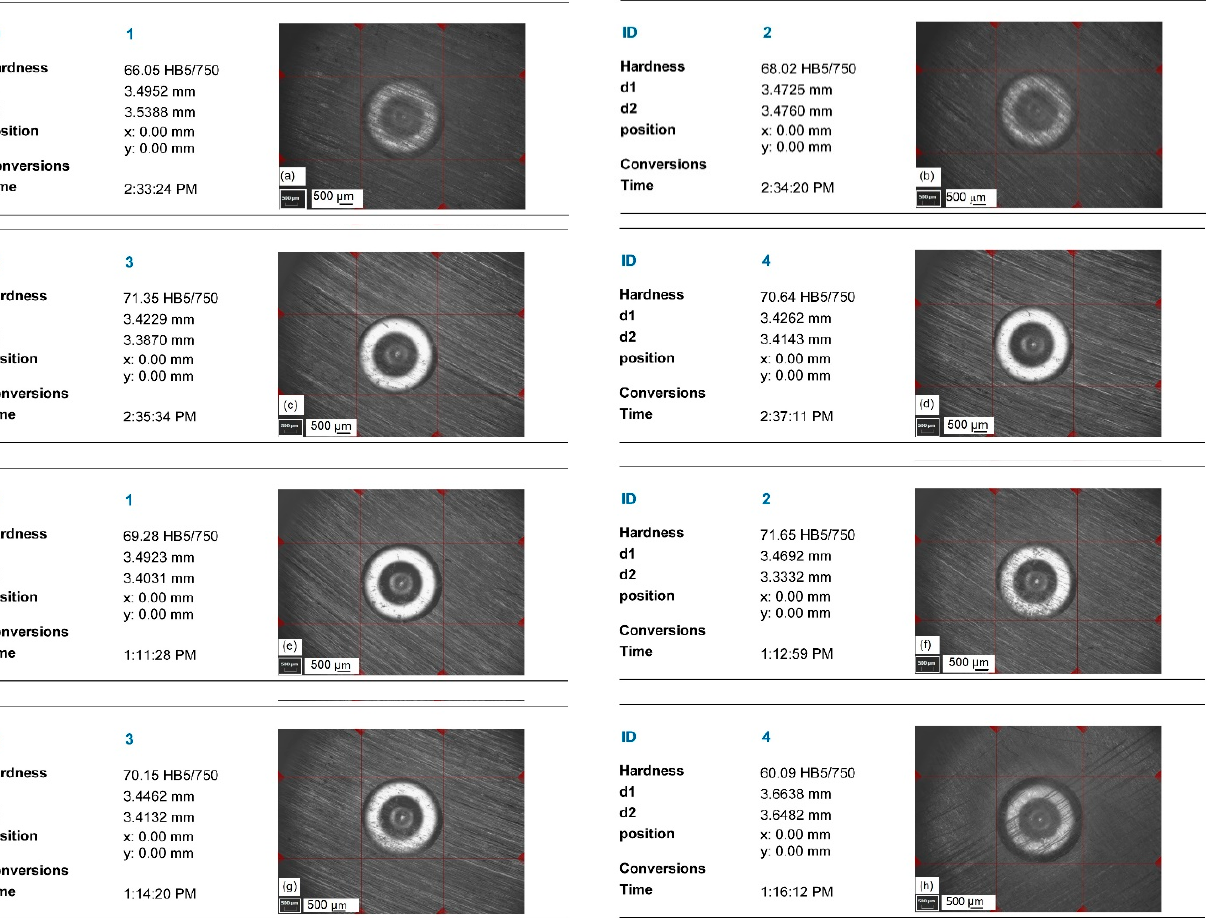
The specimen was chosen based on the cutting feed rate of at least 500 mm/min and